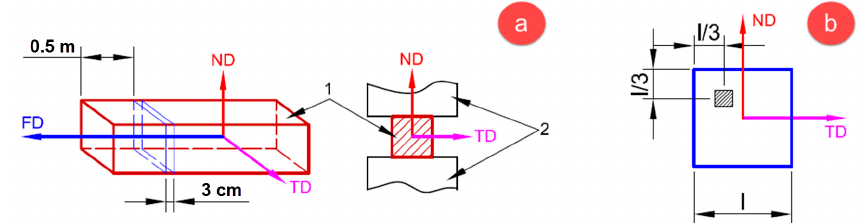
Figure 1. ( a ) Sample reference frame FD-ND-TD (FD—forging direction, ND—normal direction, TD—transverse direction), 1—forged bar, 2—forging anvils; ( b ) Forged bar slice showing the location of area sampling.